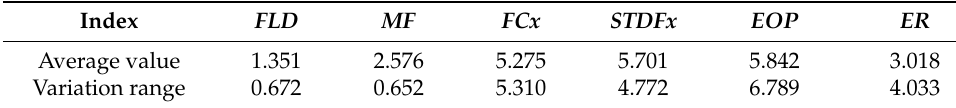
Table 8. Useful features of the tracking error.